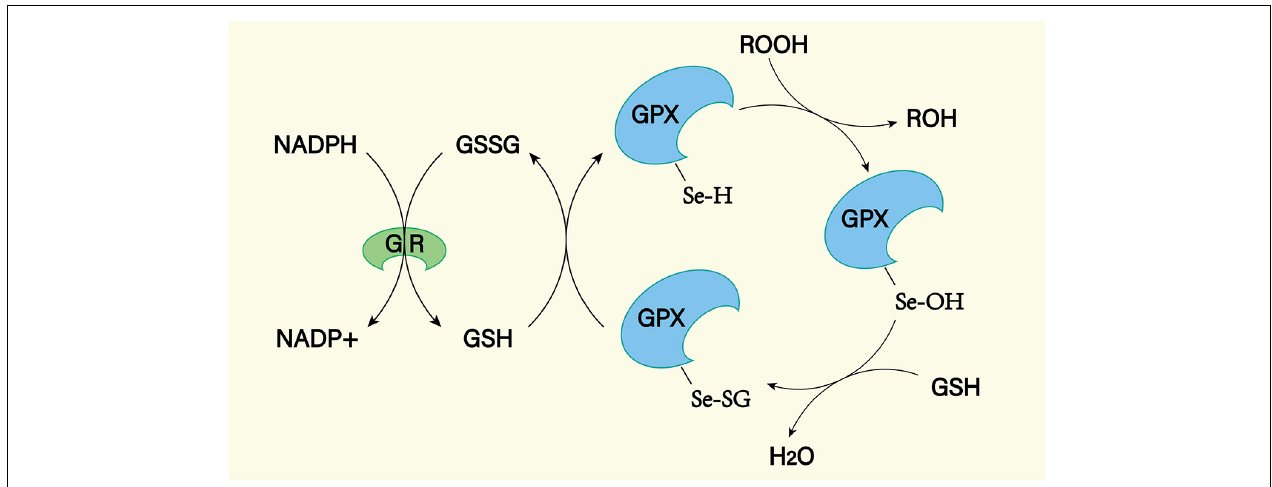
FIGURE 10 | The GPX mediated reduction of hydrogen peroxide and lipid hydroperoxides involves the formation of multiple intermediates with the assistance of glutathione (GSH). The selenol (–SeH) of GPX reacts with peroxides to form selenic acid (Se-OH). Then the selenic acid is reduced by GSH to form the Se-SG intermediate of GPX. GPX-Se-SG was reduced by the second GSH to form GSSG. GSSG can be reduced by glutathione reductase (GR) as reduced equivalent by